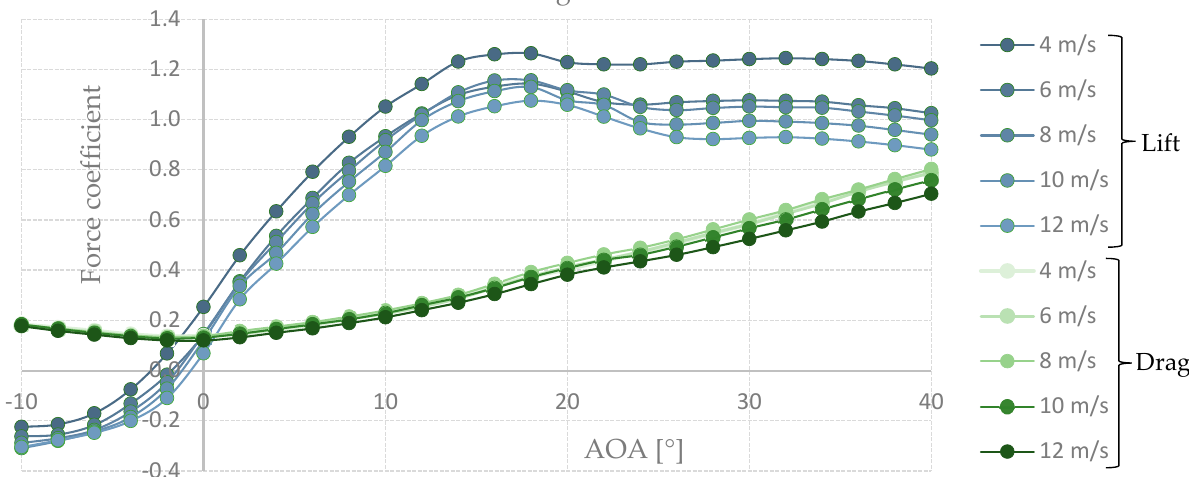
Figure 10. Lift and Drag coefficient against angle of attack.